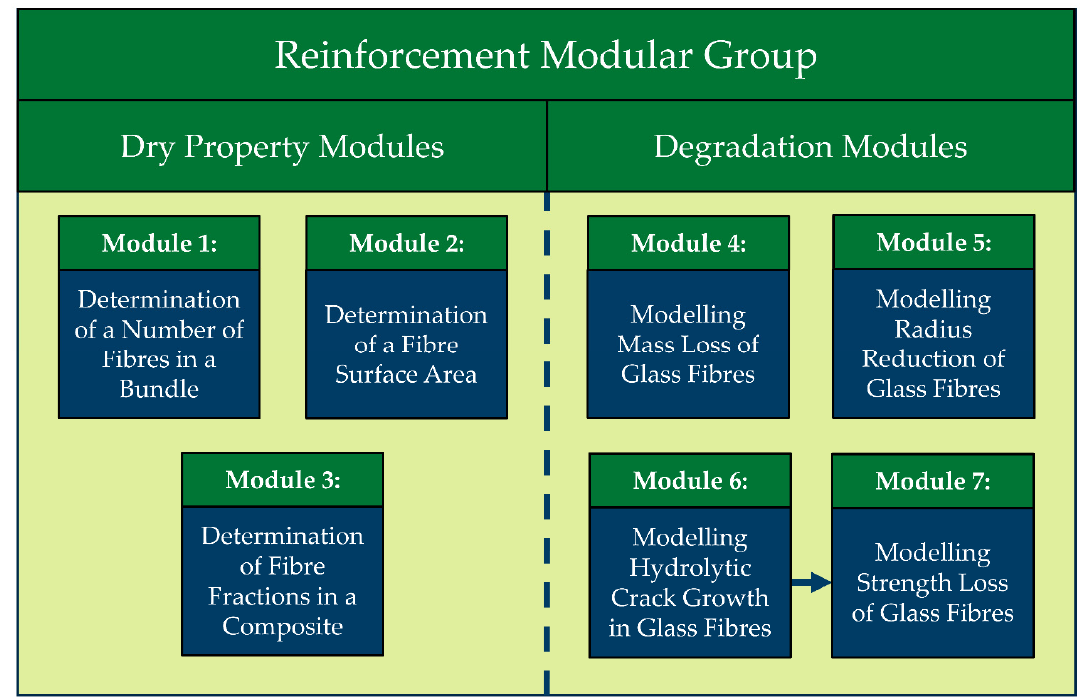
Figure 2. The seven developed modules of the Reinforcement Modular Group within the Modular Paradigm.